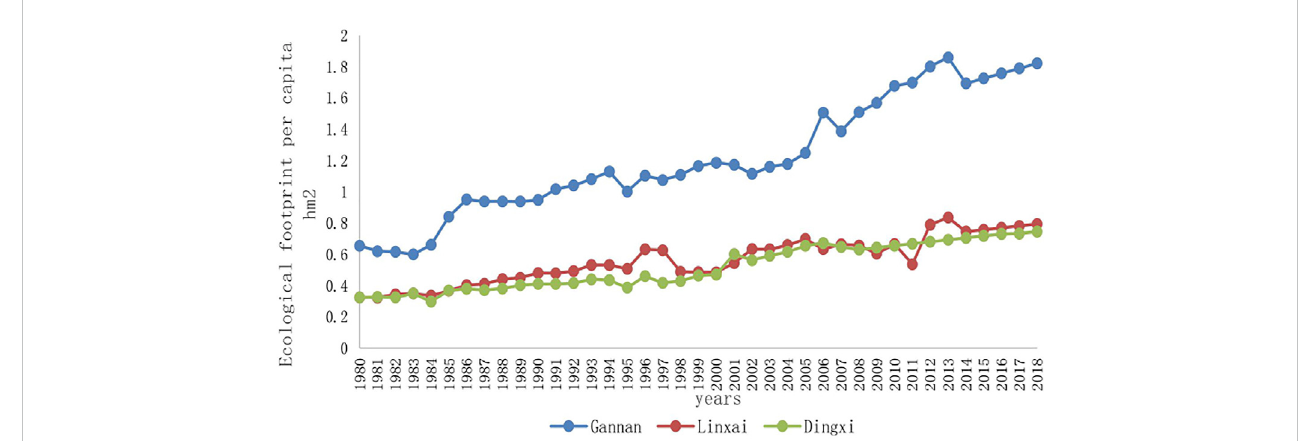
FIGURE 2 Comparison of per capita ecological footprints (de fi cit) of the three places from 1980 to 2018.